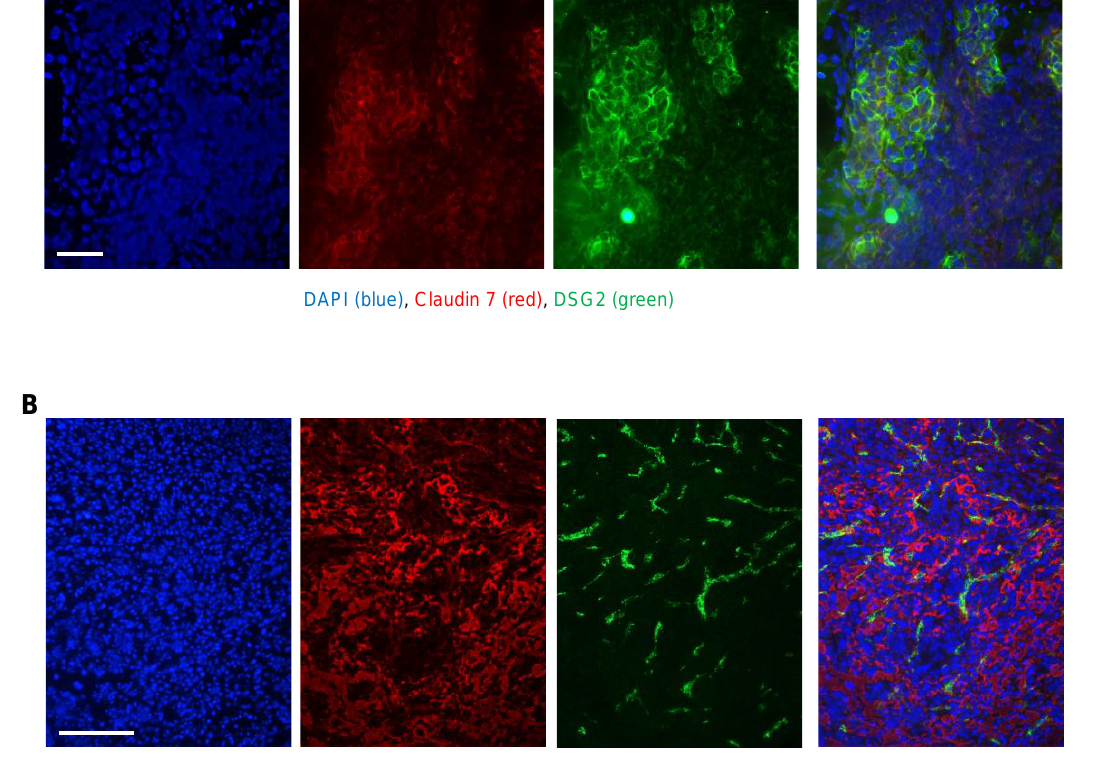
Figure 4. Immunofluorescence analysis of TC1-DSG2 tumor sections. Tumors were harvested when they reached a volume of 500 – 600 mm 3 , embedded in OCT, and sectioned. ( A ) Sections were stained for (human) DSG2 (green) and the epithelial marker claudin 7 (red). Visible are nests of human DSG2-postitive tumor cells embedded in tumor stroma cells (mouse-derived). ( B ) Sections were stained for the extracellular matrix/stroma protein (red) and the endothelial/blood vessel cell marker CD31 (green). The images show a vascularized tumor with typical stroma components.